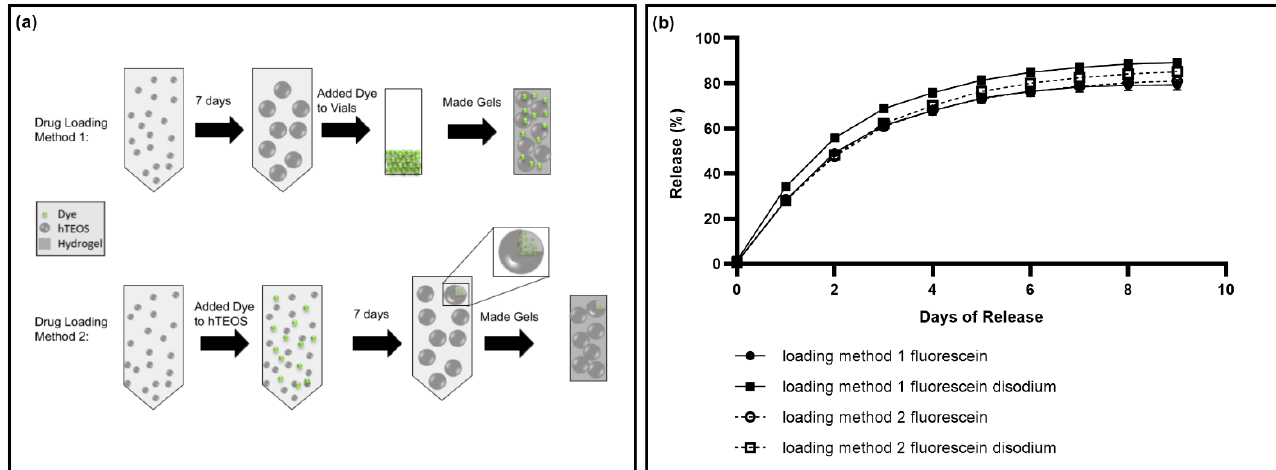
Figure 6. Evaluation of drug release using different drug loading methods. ( a ) The two different drug loading methods. In method 1, the hTEOS was made, then let sit for 7 days. After 7 days, gels were made in glass vials containing the dye, either fluorescein or fluorescein disodium. In method 2, the hTEOS was made, then then the dye was added and then let sit for 7 days, after which point the gels were made. ( b ) The release profiles of fluorescein and fluorescein disodium from gels using the two different drug loading methods from ( a ), with N = 3. Error bars are hidden by symbols when not visible. A t -test was used to compare release using method 1 versus method 2 for fluorescein and fluorescein disodium. There was no statistically significant difference between the release profiles using method 1 and 2 for fluorescein (Table S6). There was a statistically significant difference between the release of fluorescein disodium loaded using method 1 versus 2.